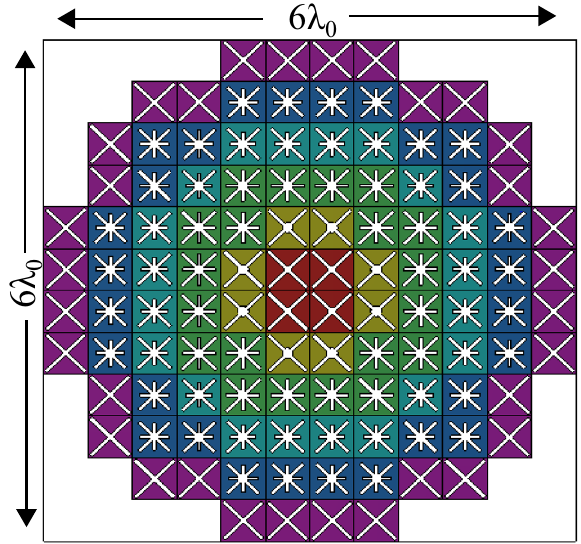
Figure 5. The layout of the dielectric-free phase-shifting cells in the DF-PTS.